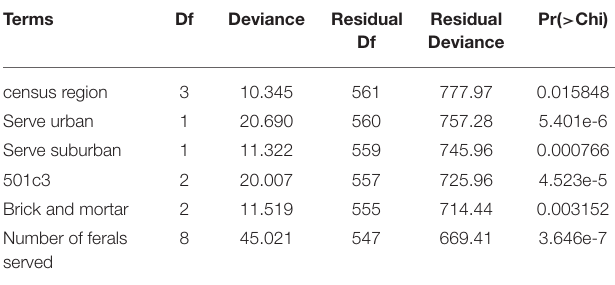
TABLE 3 | ANOVA results for terms within the best